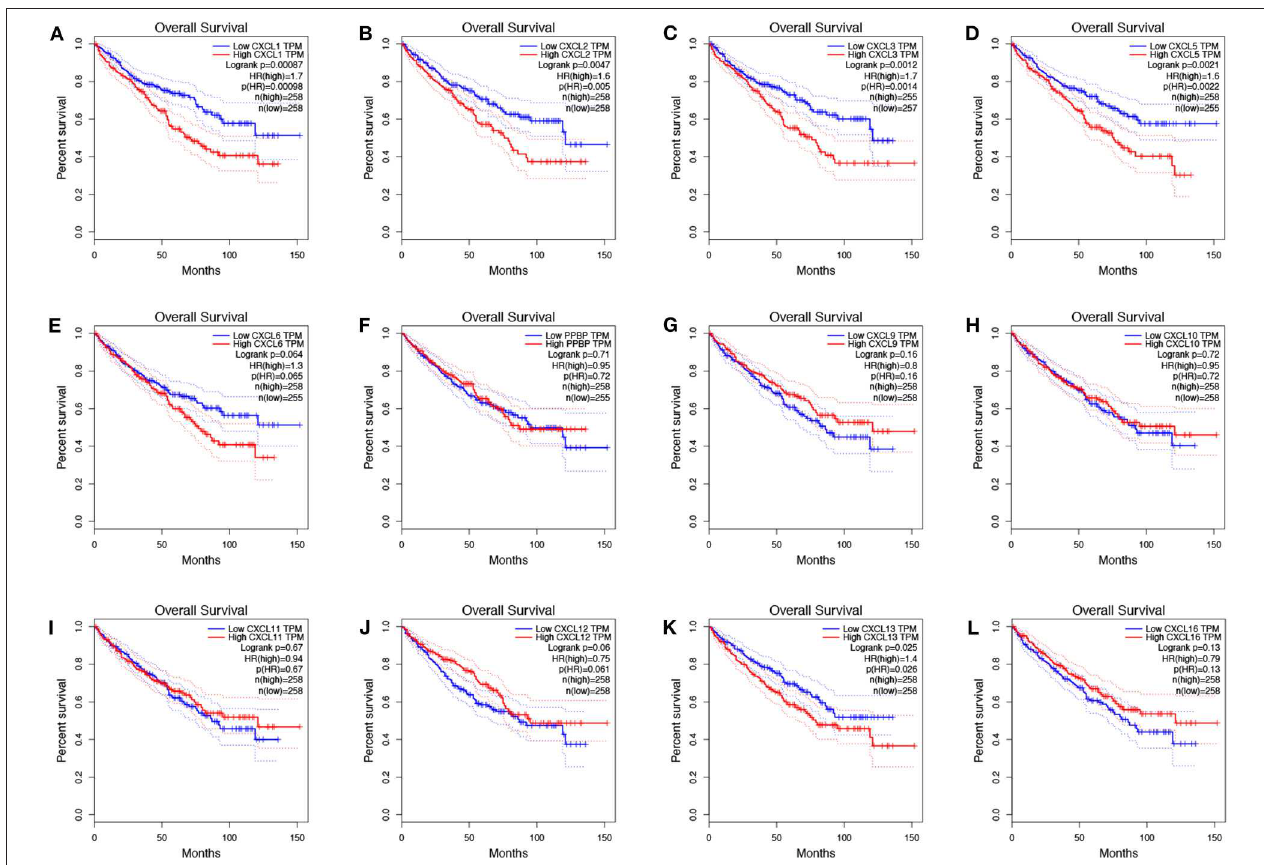
FIGURE 6 | The prognostic value of CXC chemokines in RCC patients in the overall survival curve (GEPIA). The overall survival curve of (A) CXCL1, (B) CXCL2, (C) CXCL3, (D) CXCL5, (E) CXCL6, (F) CXCL7, (G) CXCL9, (H) CXCL10, (I) CXCL11, (J) CXCL12, (K) CXCL13, and (L) CXCL16 in RCC.